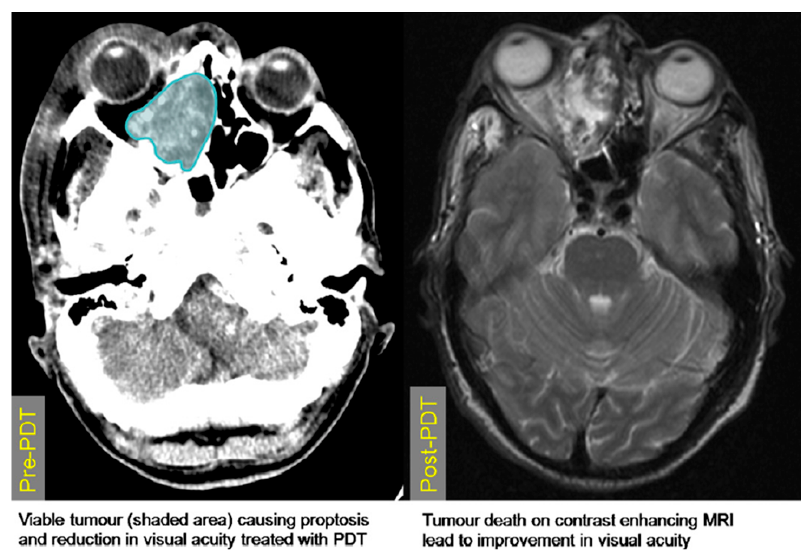
Figure 8. CT scans pre- and post-PDT of a mass located in the sinonasal area and extending into the retrobulbar space, affecting vision and causing proptosis. The post-PDT CT displays a reduction in bulk of the mass, leading to an improvement in visual symptoms. Reprinted with permission from ref. [43]. Copyright 2010 Photodiagnosis Photodyn. Ther.